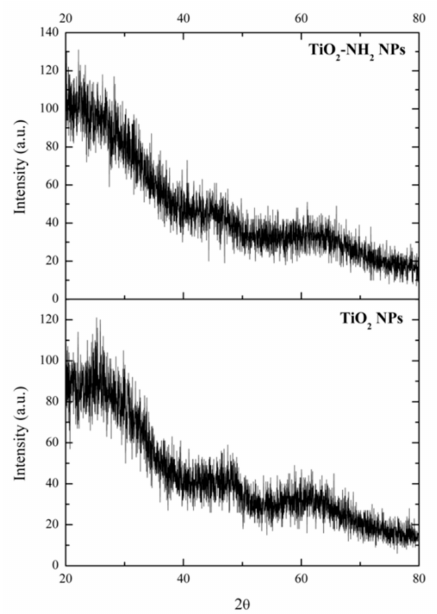
Figure 5. X-ray analysis (XRD) di ff ractograms of a-TiO 2 and a-TiO 2 -NH 2